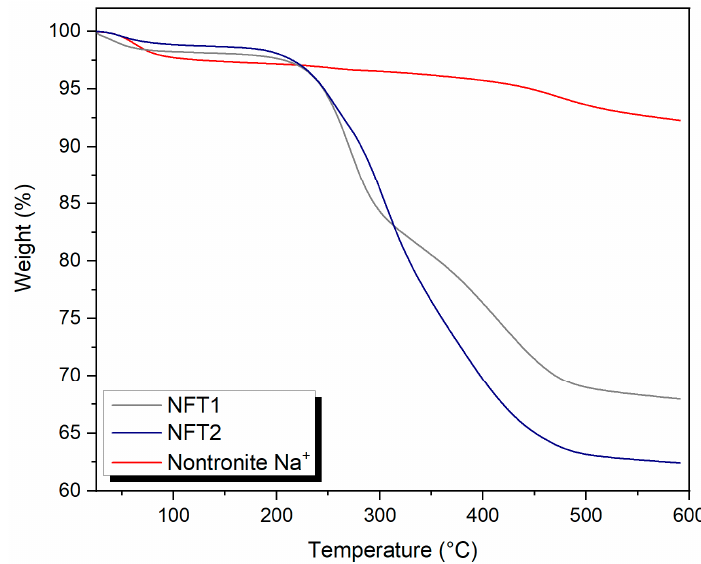
Figure 11. Thermal decomposition of treated clay and organoclays.